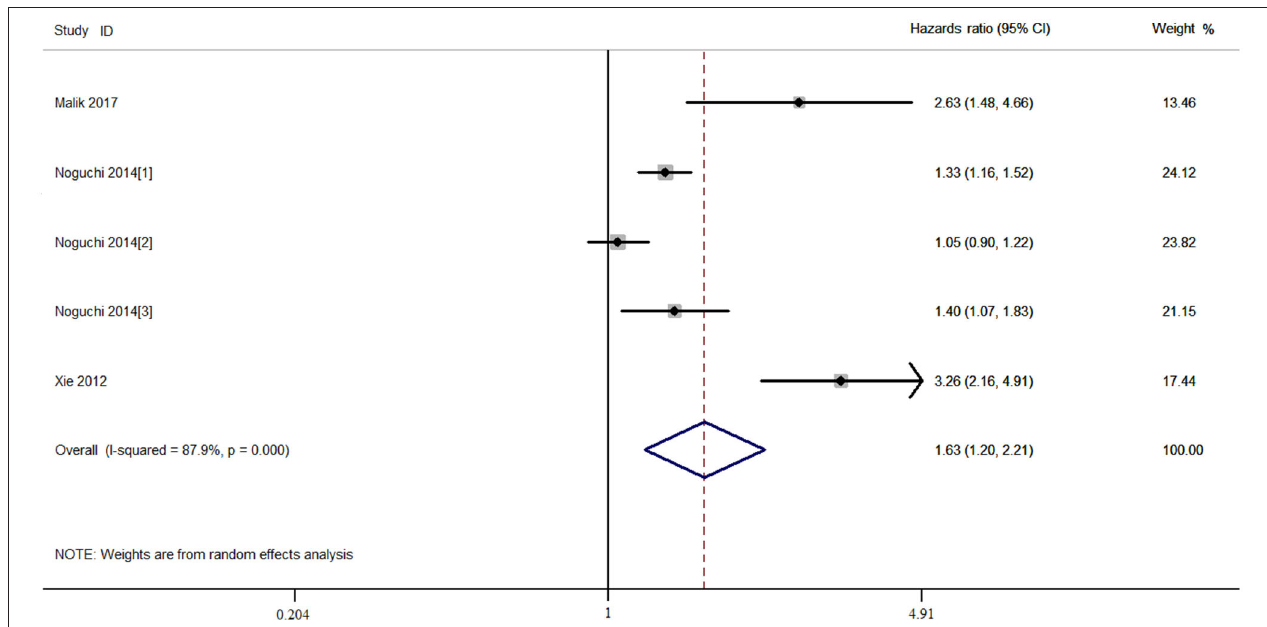
FIGURE 2 | Combined meta-analysis between transcriptional co-activator with PDZ-binding motif (TAZ) expression and overall survival of patients with non-small cell lung cancer (NSCLC).